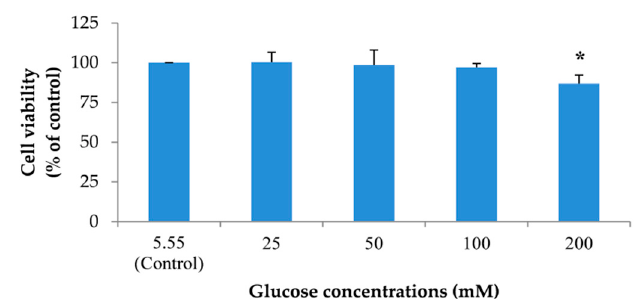
Figure 4. The effect of different concentrations of glucose on SH-SY5Y cell viability. Detection of cell viability was performed using 3-(4,5-Dimethylthiazol-2-yl)-2,5-diphenyltetrazolium bromide tetrazolium (MTT) assay. Data are presented as the means ± SD, * p < 0.05 vs. control. p values of 200 mM glucose-treated group was 0.000.